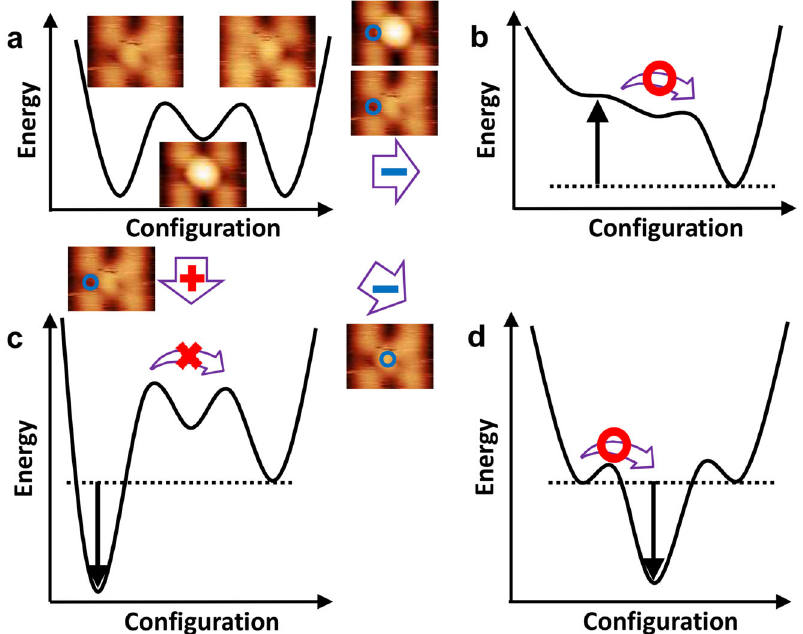
Fig. 4 Schematic potential energy landscape of manipulation. a Schematic potential energy curves of the triple well in which the triple minima correspond to O s H − (O ad H) − − O s , O s H − O ad 2 − − O s H and O s -(O ad H) − -O s H, as indicated by the images in a . b – d Schematic potential energy curves depending on the lateral position of the tip and applying a positive and negative bias between tip and sample. The black arrow indicates the perturbation of the potential landscape owing to the electric fi eld. The real potential energy for describing the manipulation is much more complicated, and many factors may need to be considered, such as the local adsorbate charge, subsurface effect and the precise shape of the tip. The tip position is indicated by a blue circle in the AFM